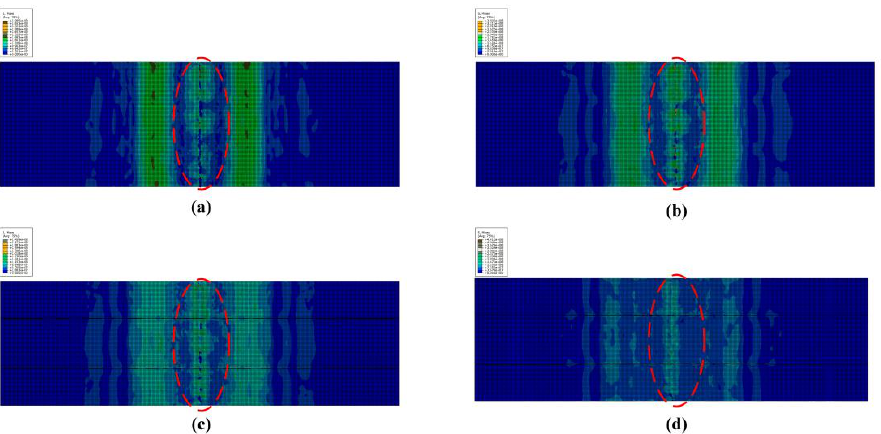
Figure 17. Damage contours of layers 2–5 above the neutral layer of SMAHC laminates. ( a ) Second layer, ( b ) Third Layer, ( c ) Fourth layer, ( d ) Fifth layer.